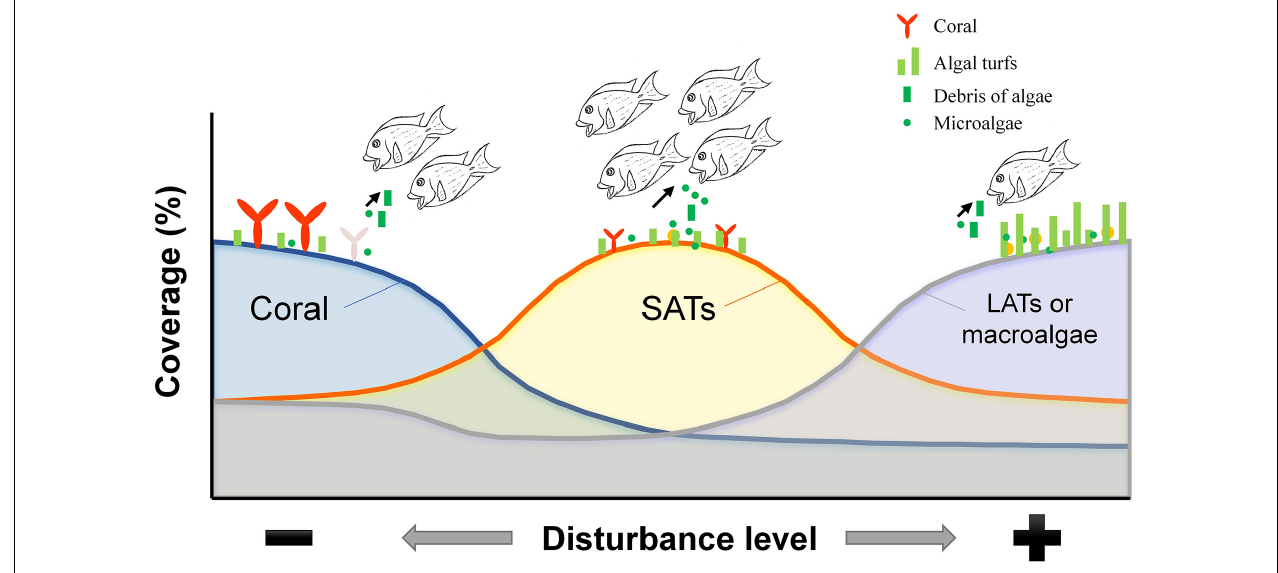
FIGURE 6 | Schematic diagram showing the influence of the substratum on the feeding of C. striatus during algal succession. The DNA sequences of macroalgae and filamentous algae were more frequently detected in the diets of C. striatus sampled from either coral-dominated reefs or macroalgae-dominated reefs, where the biomass of C. striatus was relatively lower. Reefs with intermediate levels of coral cover have more areas of substrate exposed which are covered by short algal turfs, which C. striatus preferentially feeds on. This can be seen from the high biomass of C. striatus and the high diversity and relative read abundance of dinoflagellates detected in the stomach contents of C. striatus on these